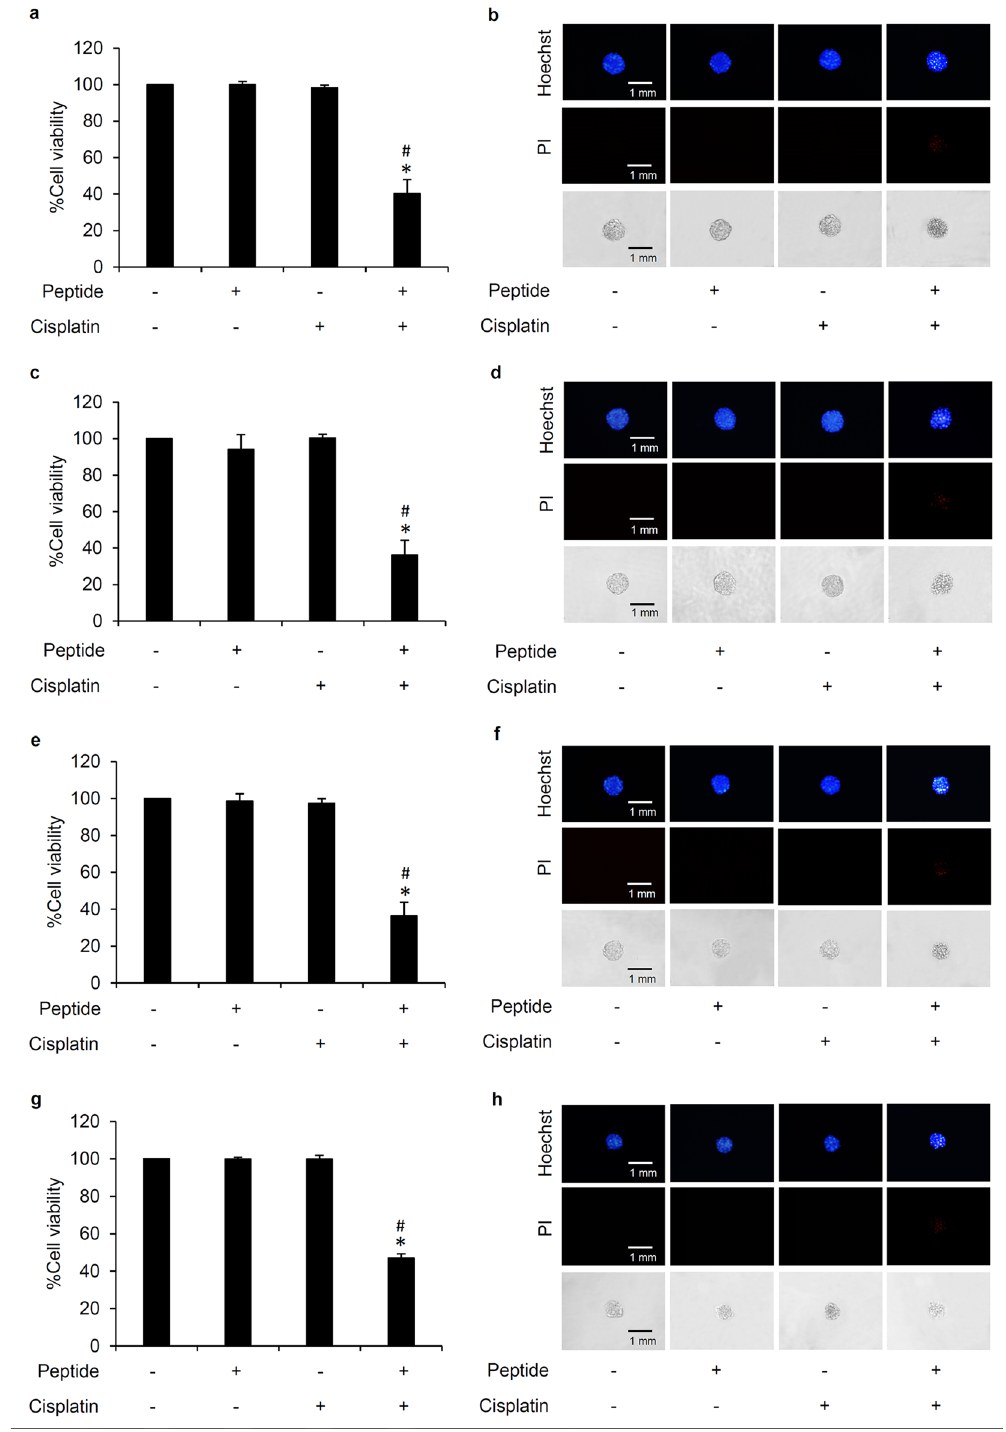
Figure 7. Chemosensitizing effect of L. squarrosulus peptide in multicellular lung cancer spheroids. PrestoBlue assay presented the significant reduction of %cell viability in cancer spheroids obtained from lung cancer ( a ) H460, ( c ) H23, (e) H292 and ( g ) A549 cells that were cultured with 0.4 M NaCl peptide (5 µg/mL) for 24 h prior to 24 h treatment of 5 µM cisplatin. Nuclear staining clearly depicted the elevation of apoptosis observed as bright blue fluorescence of Hoechst33342 in multicellular spheroids of ( b ) H460, ( d ) H23, ( f ) H292 and ( h ) A549 cells after coculture with L. squarrosulus peptide and cisplatin. Notably, the presentation of both bright blue Hoechst33342 fluorescence and red fluorescence of propidium iodide (PI) indicated late stage of apoptosis detected in the spheroids after preincubation with 0.4 M NaCl peptide followed by cisplatin treatment. Values are means of three independent experiments ± SD. * p < 0.05 versus non-treated control cells, # p < 0.05 versus the cells treated only with